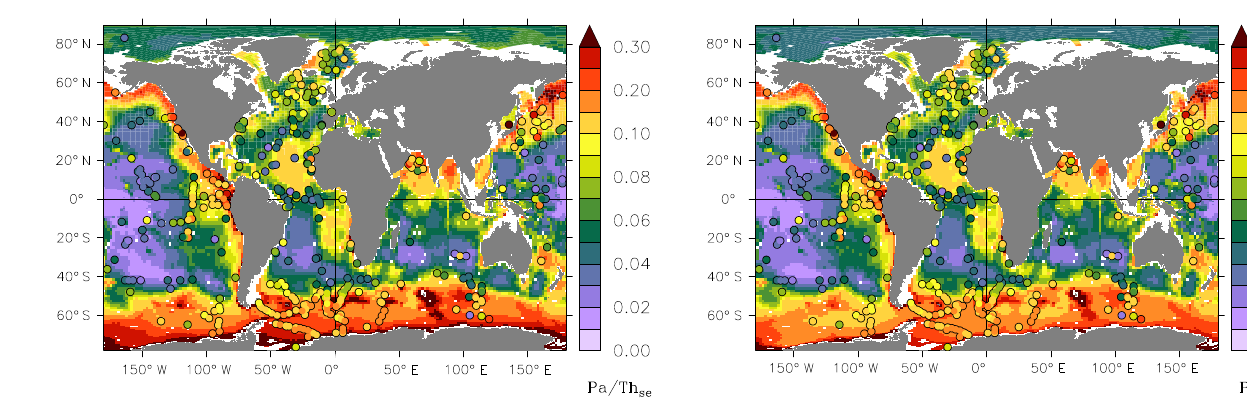
Figure 11. Sedimented 231 Pa / 230 Th ratio when we set = 0 . 4. Top core measurements are pre- K Pa , bSiO /K Th , bSiO 2 2 sented as